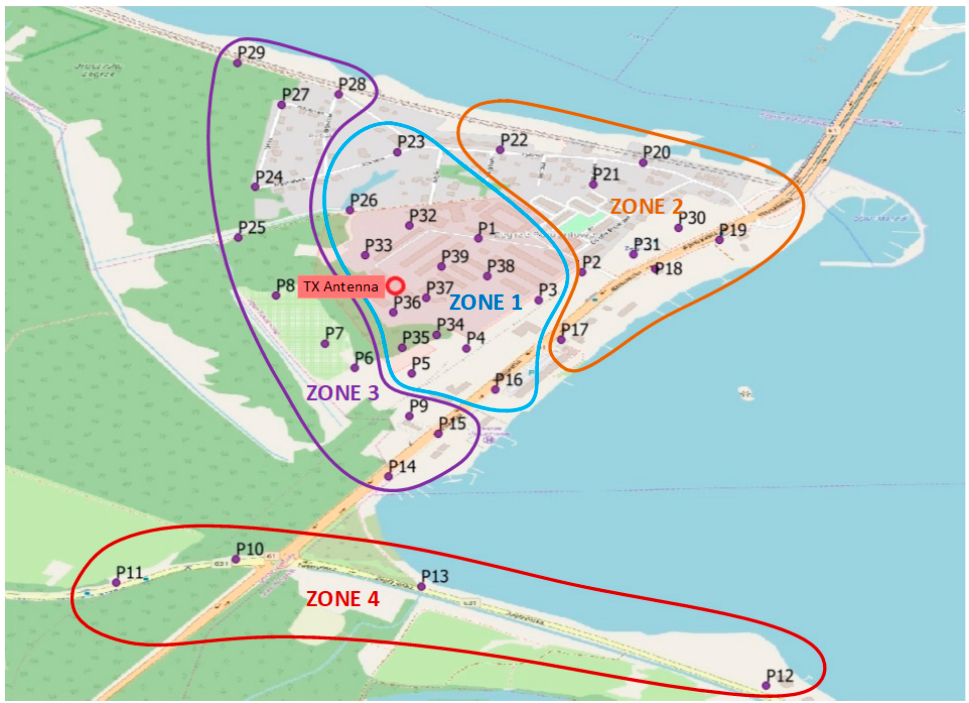
Figure 2. Deployment of the sensors and position of the TX Antenna.